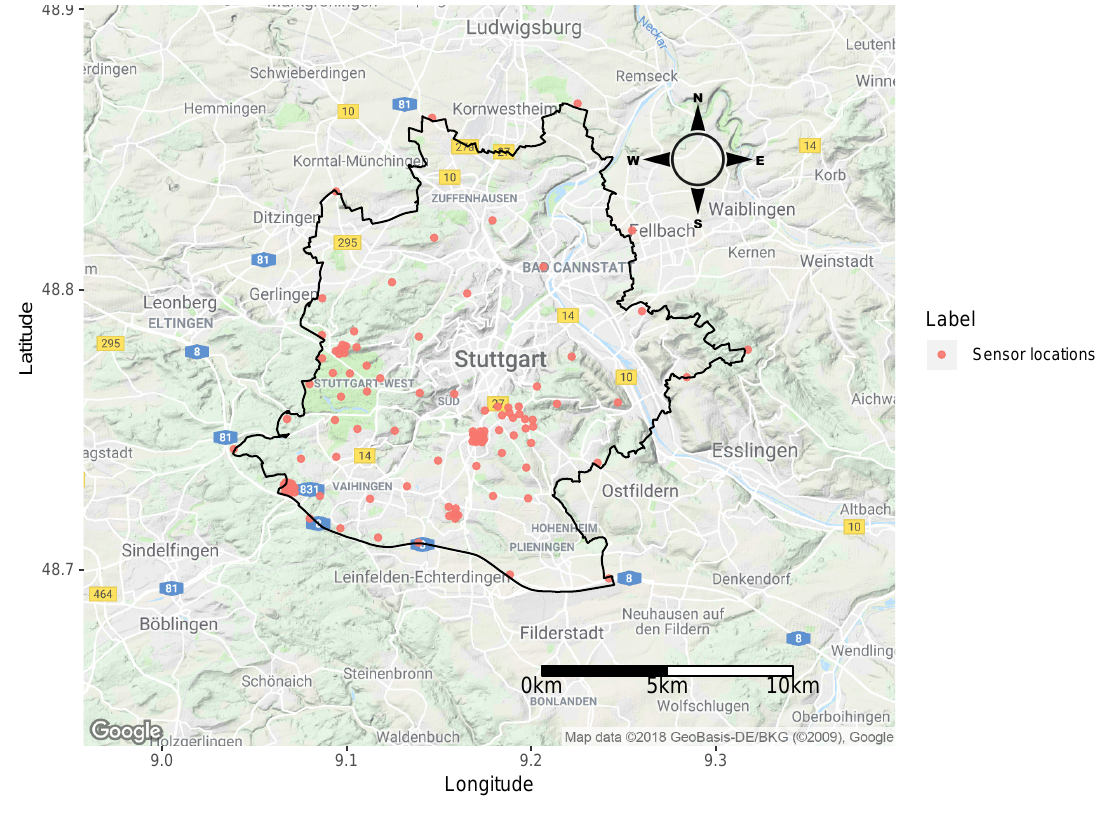
Figure 5. Optimisation outcome considering the equal weight on both wide-spread as well as prediction error aspect of the objective function ( N = 116).